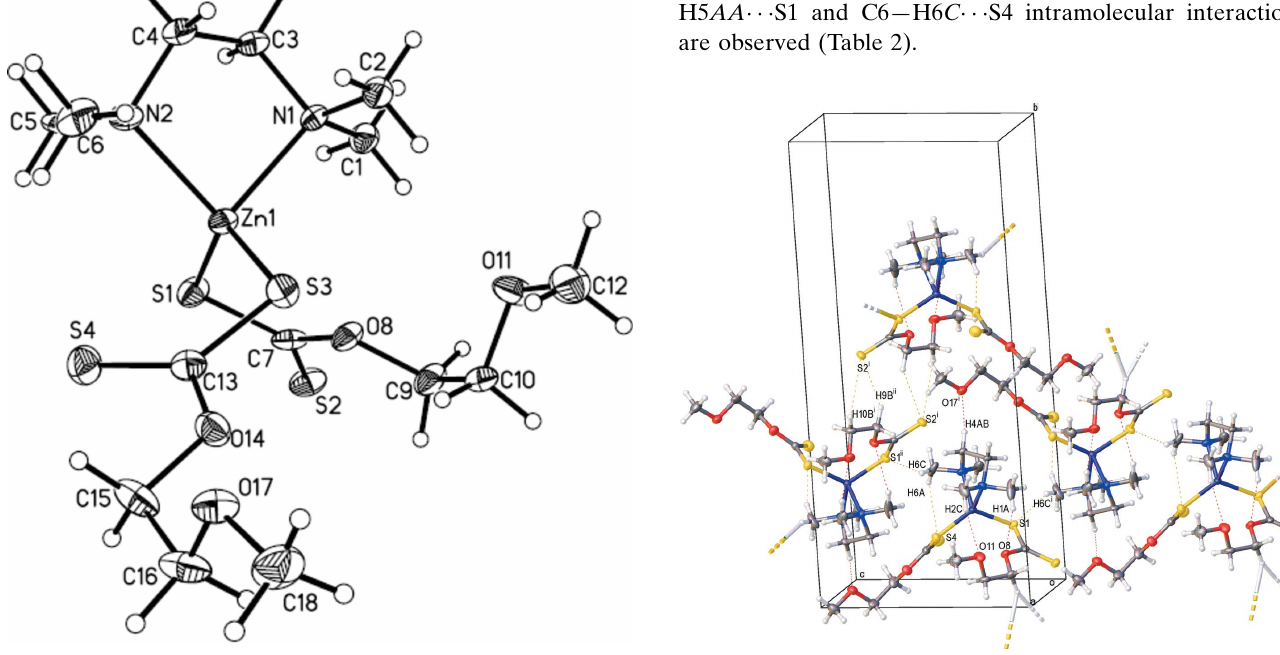
Figure 1 The molecular structure of the title complex, with the atom labelling. Only the major component of the disordered amine ligand is shown. Displacement ellipsoids are drawn at the 50% probability level.